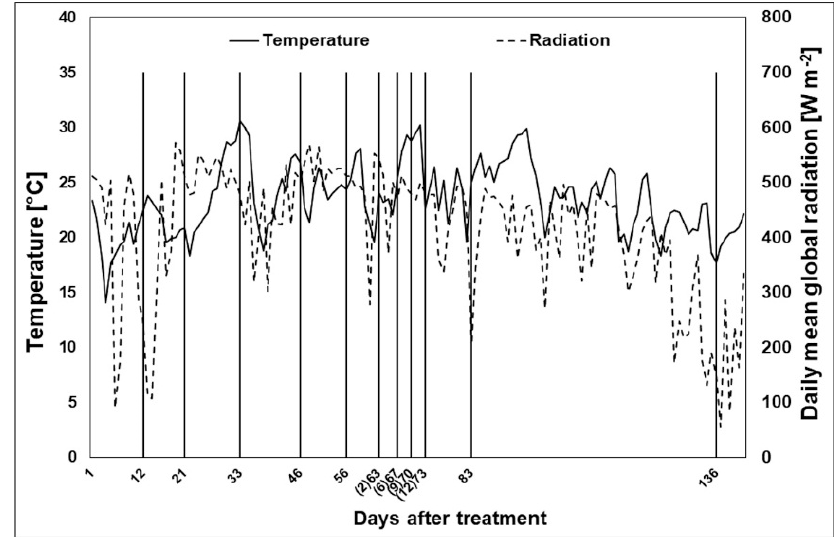
Figure 1. Meteorological data recorded during the experimental period. Average daily temperature (continuous line) and radiation (dotted line) recorded during the days of measurements (vertical black line). The days after drought treatment are reported in brackets.